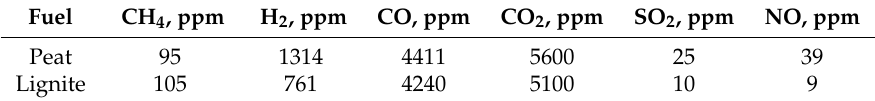
Figure 4. Chemical composition of syngas vs. light flow intensity. The normalization factors of concentrations of each gas are shown in Table 3. Table 3. Normalization factors for the concentrations of syngas components presented in Figure